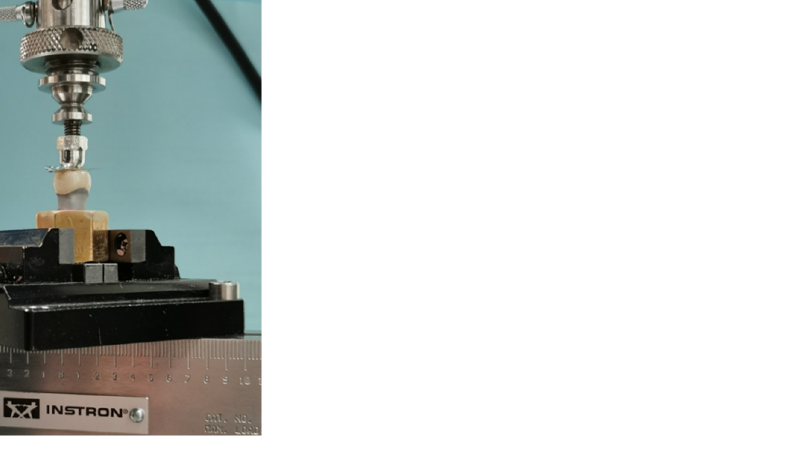
Figure 6. Crown set up for cyclic loading in the electro-dynamic testing